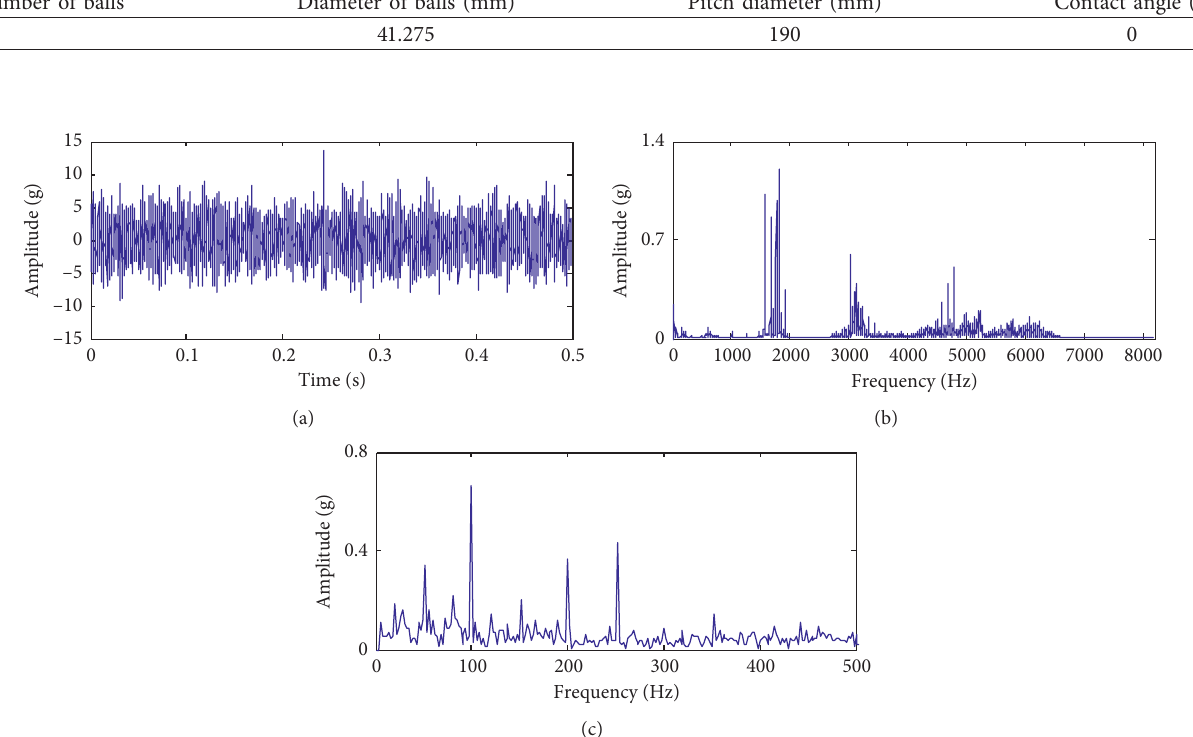
Figure 20: The collected engineering signal: (a) the waveform; (b) the frequency spectrum; (c) the envelope